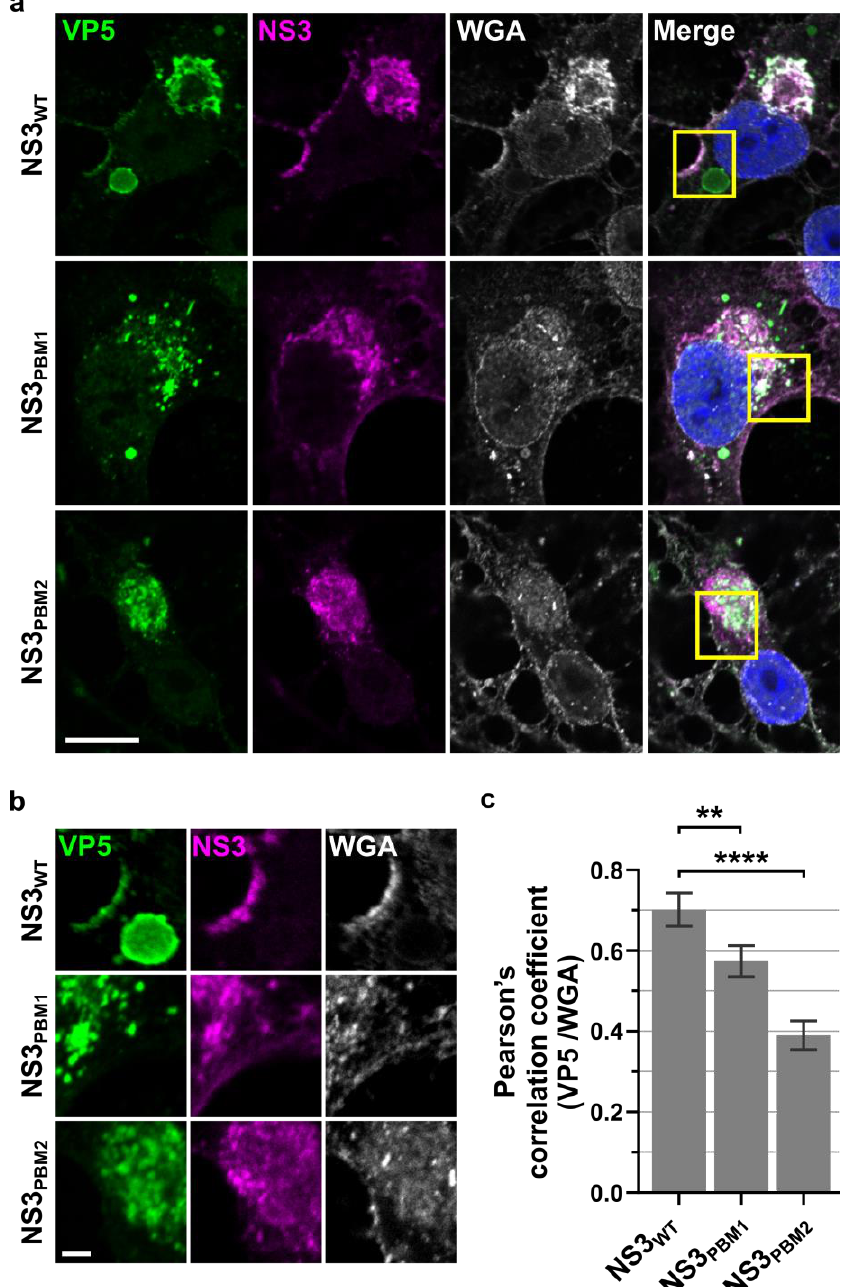
Figure 5. NS3 trafficking mutants affect VP5 export to the plasma membrane. ( a ) Confocal microscopy images of VP5 (green) and NS3 (purple) in BSR cells infected by either WT BTV (top row), BTV NS3PBM1 (middle row), and BTV NS3PBM2 (bottom row) viruses 24 h.p.i, and labelled with the membrane fluorescent marker Wheat germ agglutinin (WGA, white). The nucleus is shown in blue, and the scale bar represents 10 μm (white line, bottom left corner). The squares represent the region of interest magnified and shown in ( b ), where the scale bar represents 2 µm (white line). The colocalization between WGA and VP5 in whole cells was quantified for each virus using ( c ) the Pearson’s correlation coe ffi cient. The data are depicted as means and SD; n = 30; ** p < 0.01; **** p <